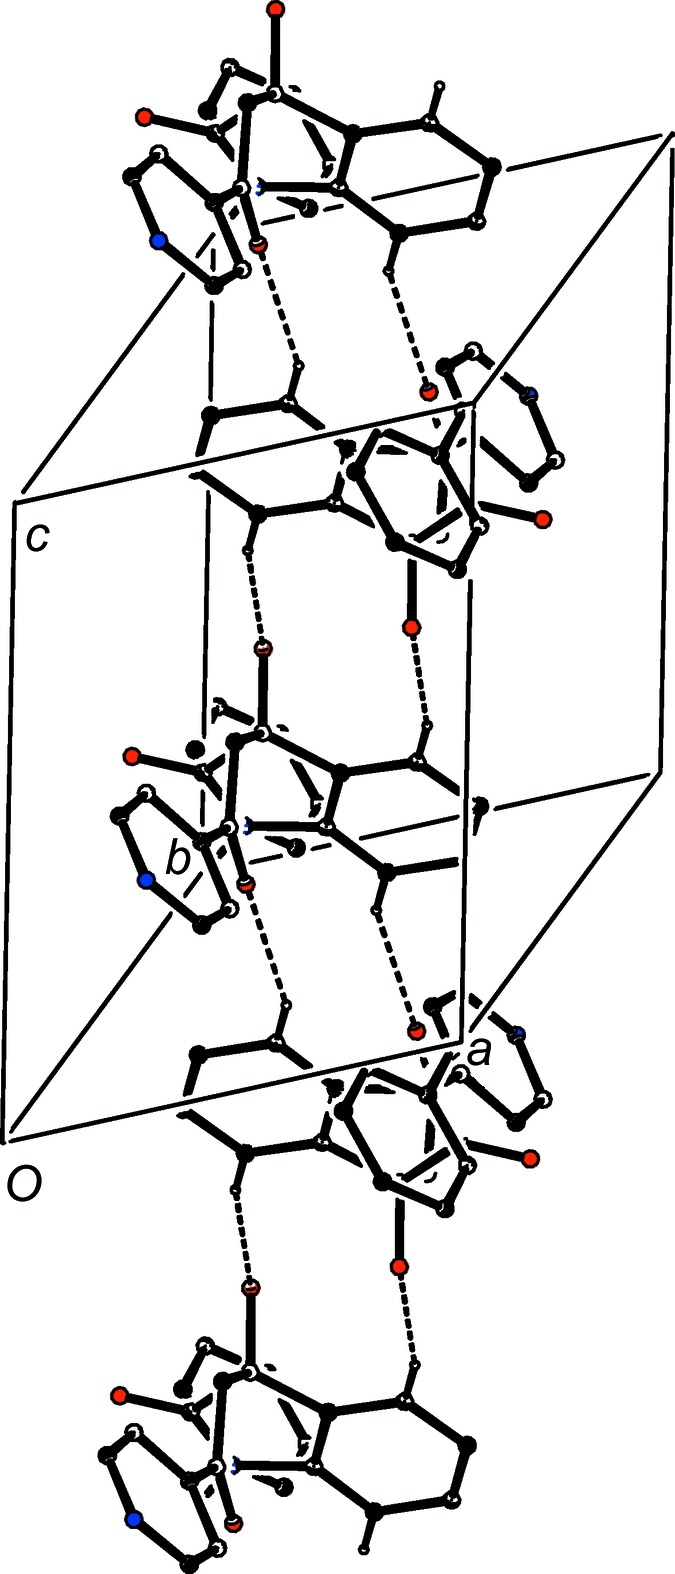
Part of the crystal structure of com­pound (Ie), showing the formation of a chain of rings running parallel to the [001] direction and built from two types of C—H⋯O hydrogen bonds. Hydrogen bonds are drawn as dashed lines and, for the sake of clarity, H atoms not involved in the motifs shown have been omitted.